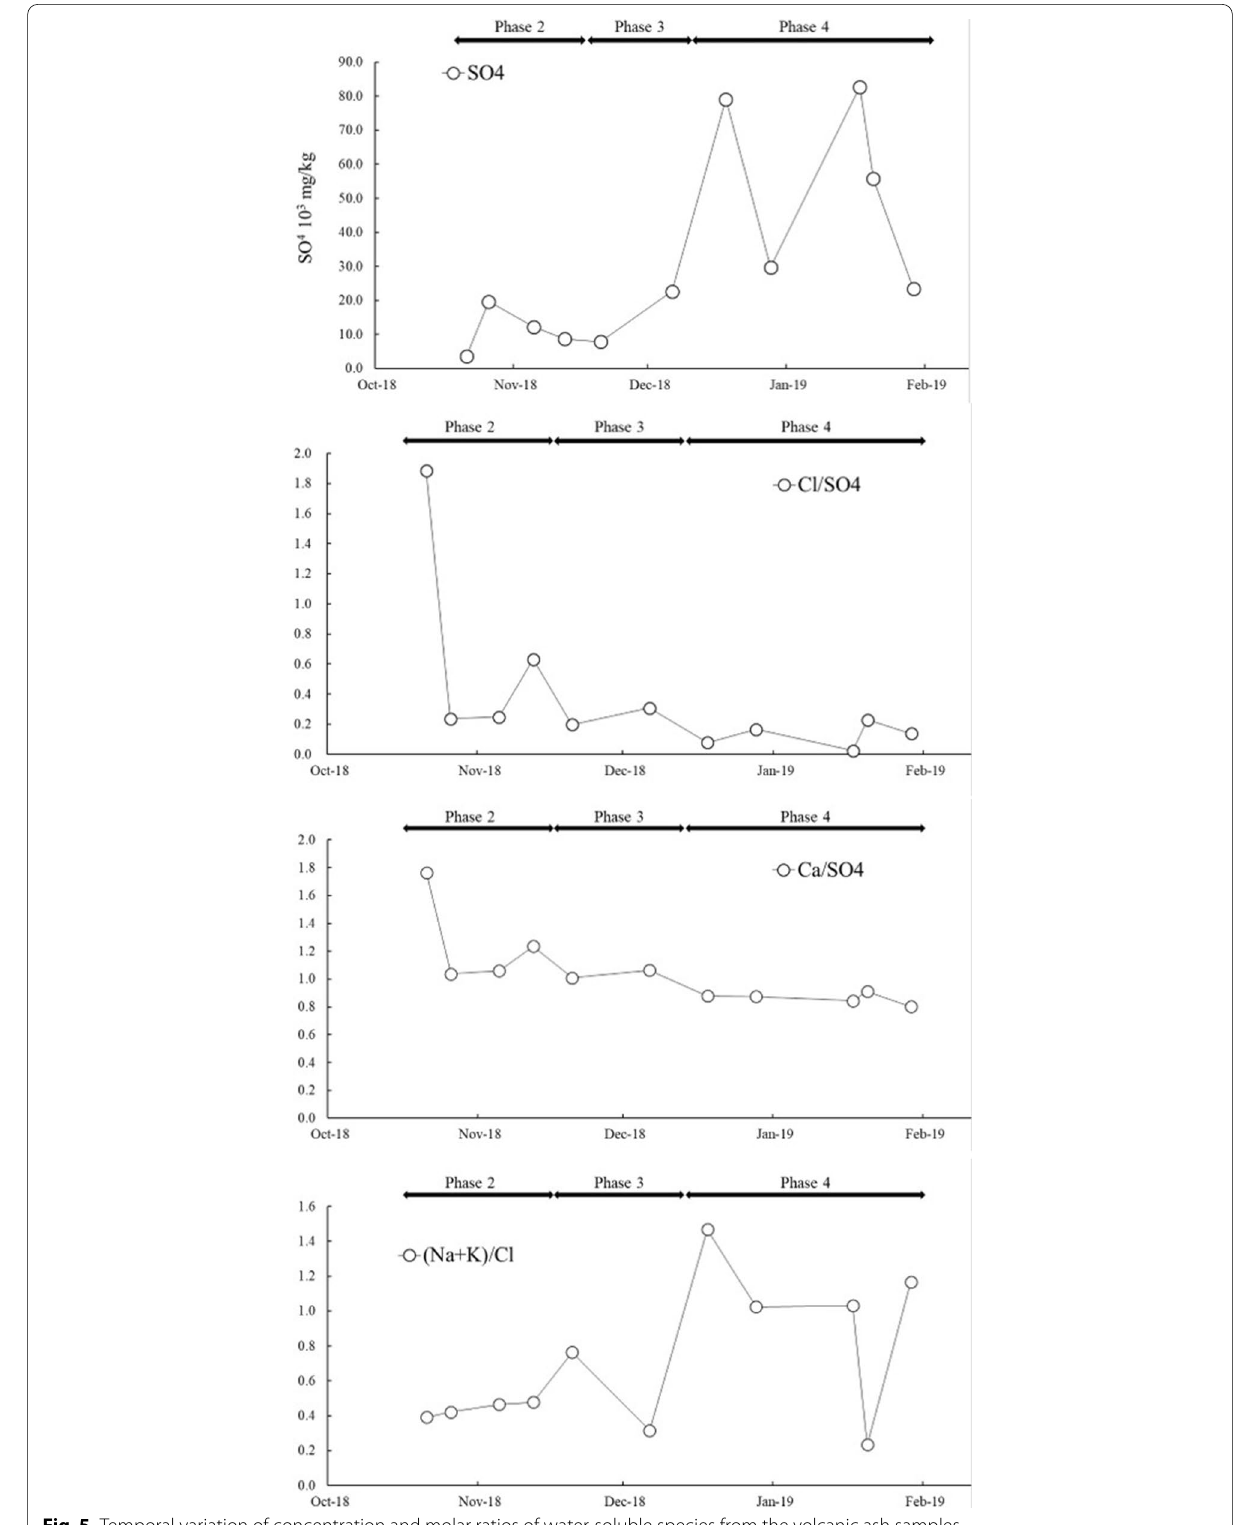
Fig. 5 Temporal variation of concentration and molar ratios of water-soluble species from the volcanic ash